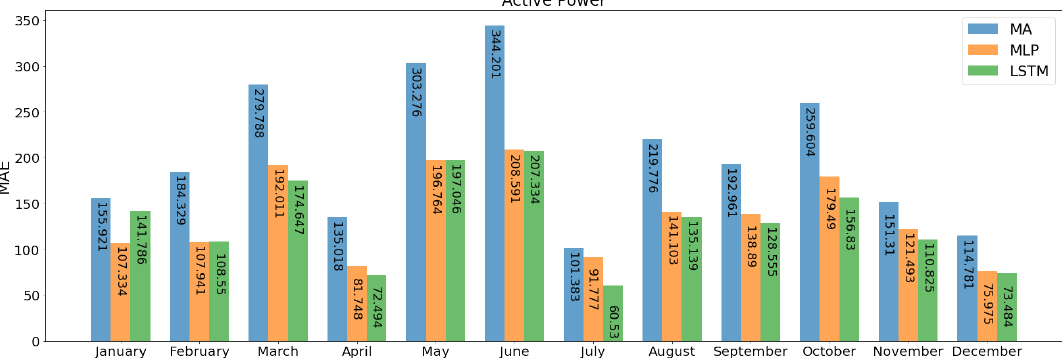
Figure 22. The performance metric (MAE) comparison for active power prediction for the whole